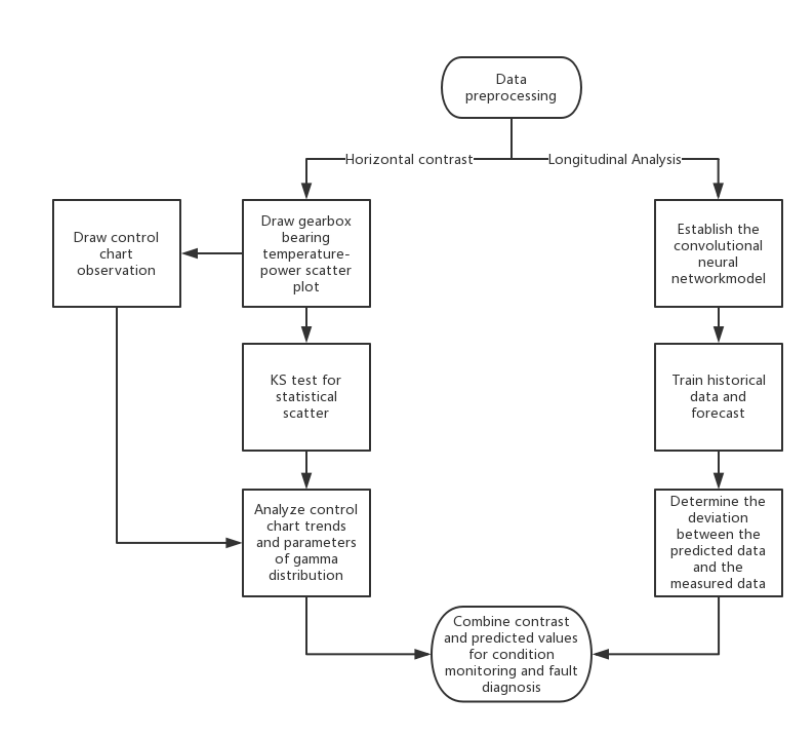
Figure 1. Block diagram of the overall structure of the